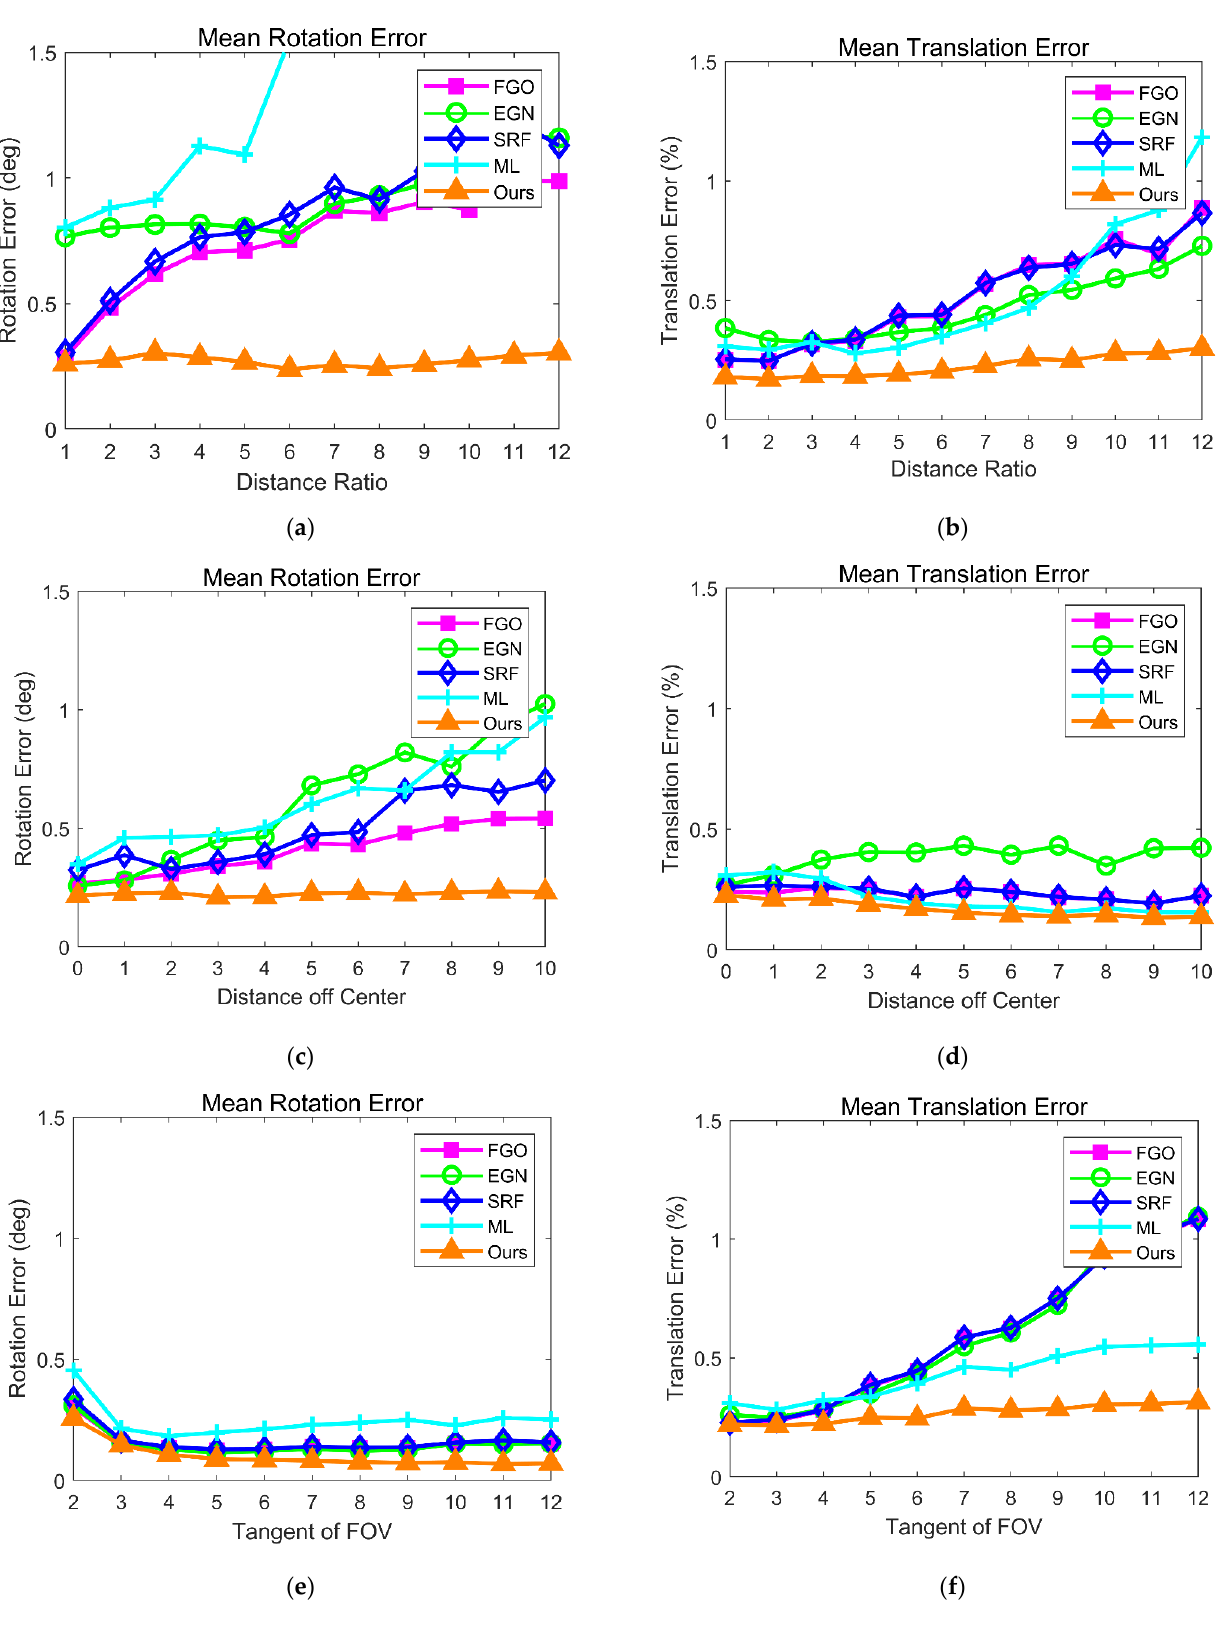
Figure 6. The accuracies of pose determinations with respect to ( a , b ) the distance ratio, ( c , d ) the distance off center, and ( e , f ) the tangent of FOV, respectively.